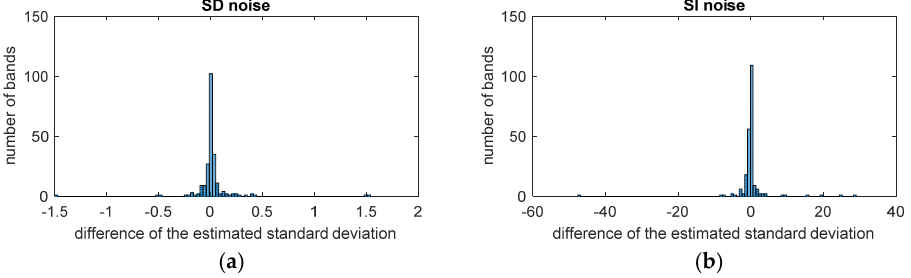
Figure 19. A histogram of the differences between the estimated standard deviations of the two datasets: (a) the SD noise, and (b) the SI noise.